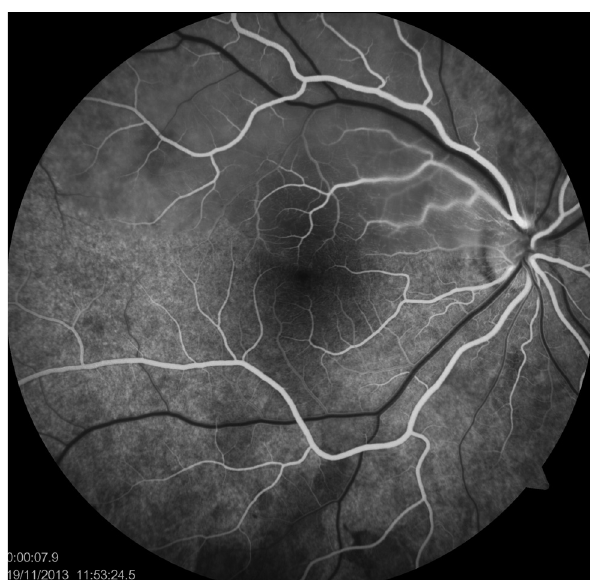
Fig. 1. Right eye. Intensive edema of the superior half of the retina, but the vessels are absolutely normal.